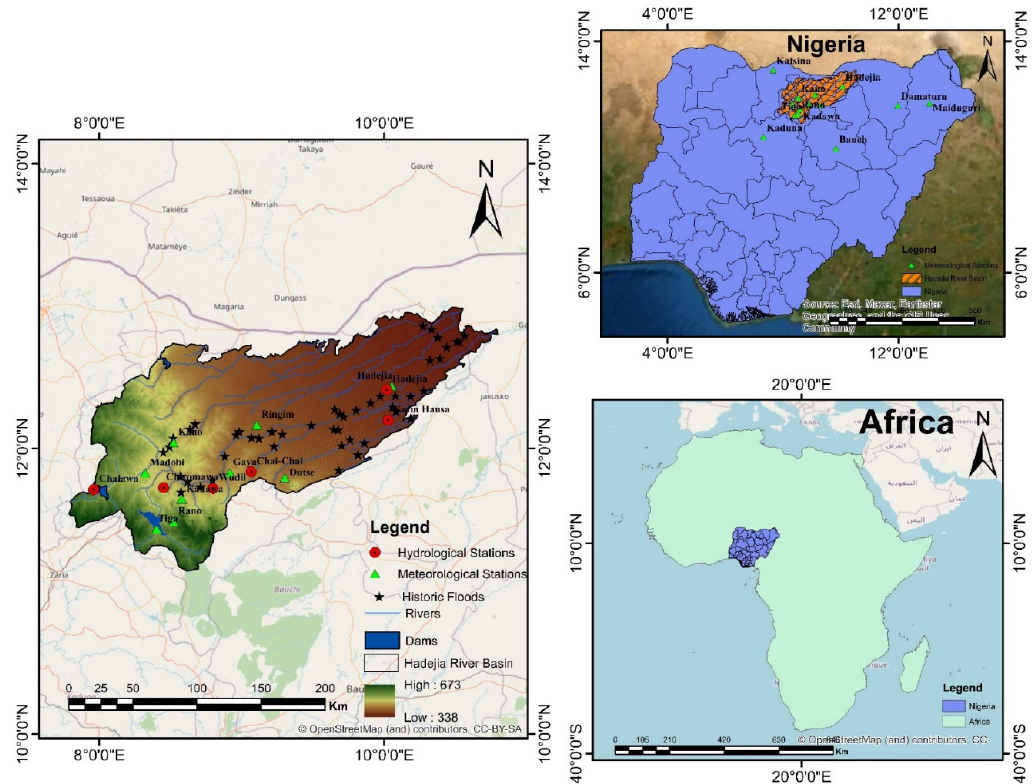
Figure 1. Location map of the study area.